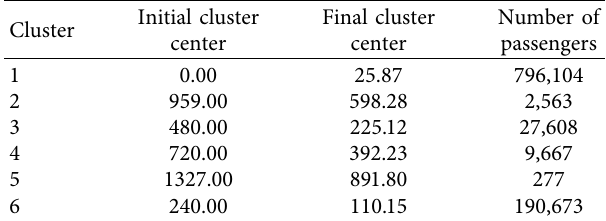
Table 10: K-means result.